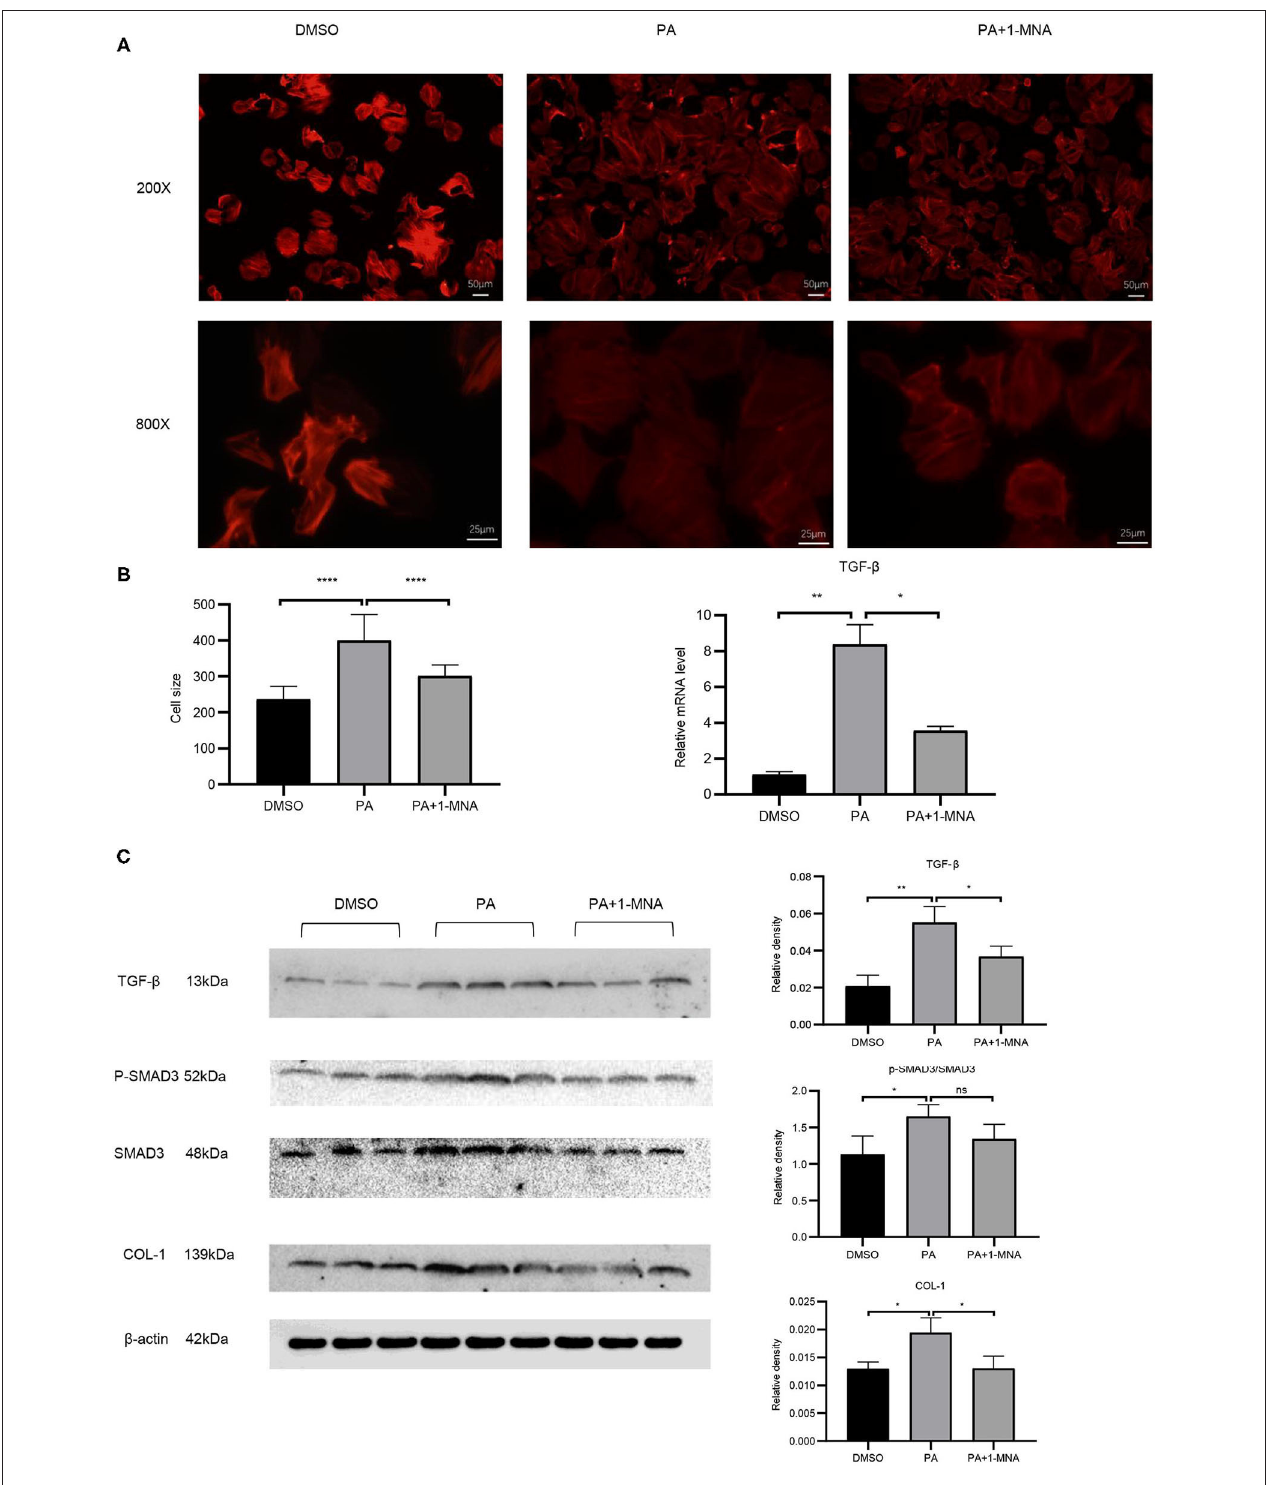
FIGURE 4 | Effects of 1-MNA on PA-induced hypertrophy and fibrosis in H9C2 cells. Representative images of H9C2 cells stained with rhodamine-phalloidin from three independent experiments. (A) Representative staining images are shown with the quantitative data for the cell size of 100 randomly selected cells in 3 independent experiments. (B ) The mRNA expression of TGF- β . (C) Western blotting analysis of TGF- β , smad2/3, p-smad2/3, and Col-1. β -actin was taken as an internal control gene. The image of the gel shown is a representative image from three independent experiments and intensity were normalized ( n = 3, NS = no significance, * P < 0.05, ** P < 0.01, **** P < 0.0001).